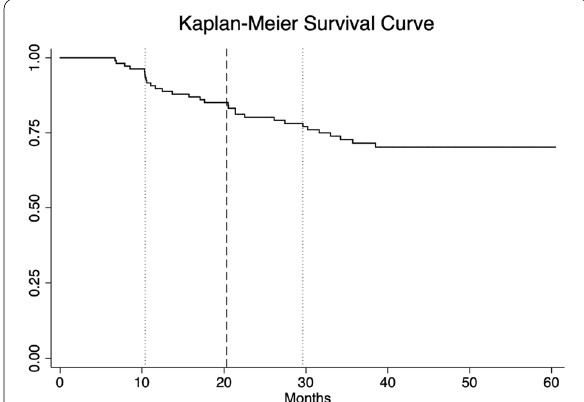
Fig. 1 Kaplan–Meier Survival Curve of recurrence rates within the four‑year follow‑up period after first‑onset postpartum psychosis. Median time to recurrence is represented by a dashed line, the interquartile range is represented by dotted lines